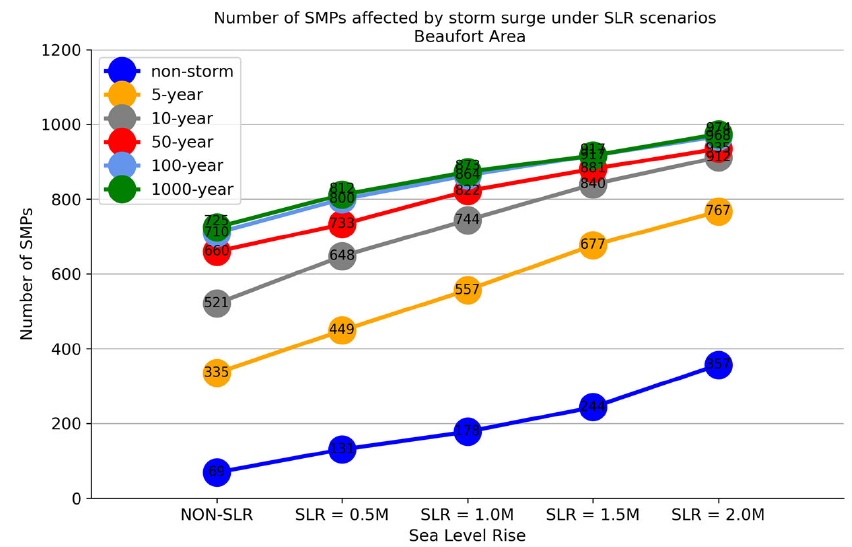
Figure 9. Beaufort area number of SMPs at risk of storm surge height with 0-year (non-storm), 5-year, 10-year, 50-year, 100-year, and 1000-year return periods under scenarios of 0 m, 0.5 m, 1.0 m, 1.5 m, and 2.0 m SLR.